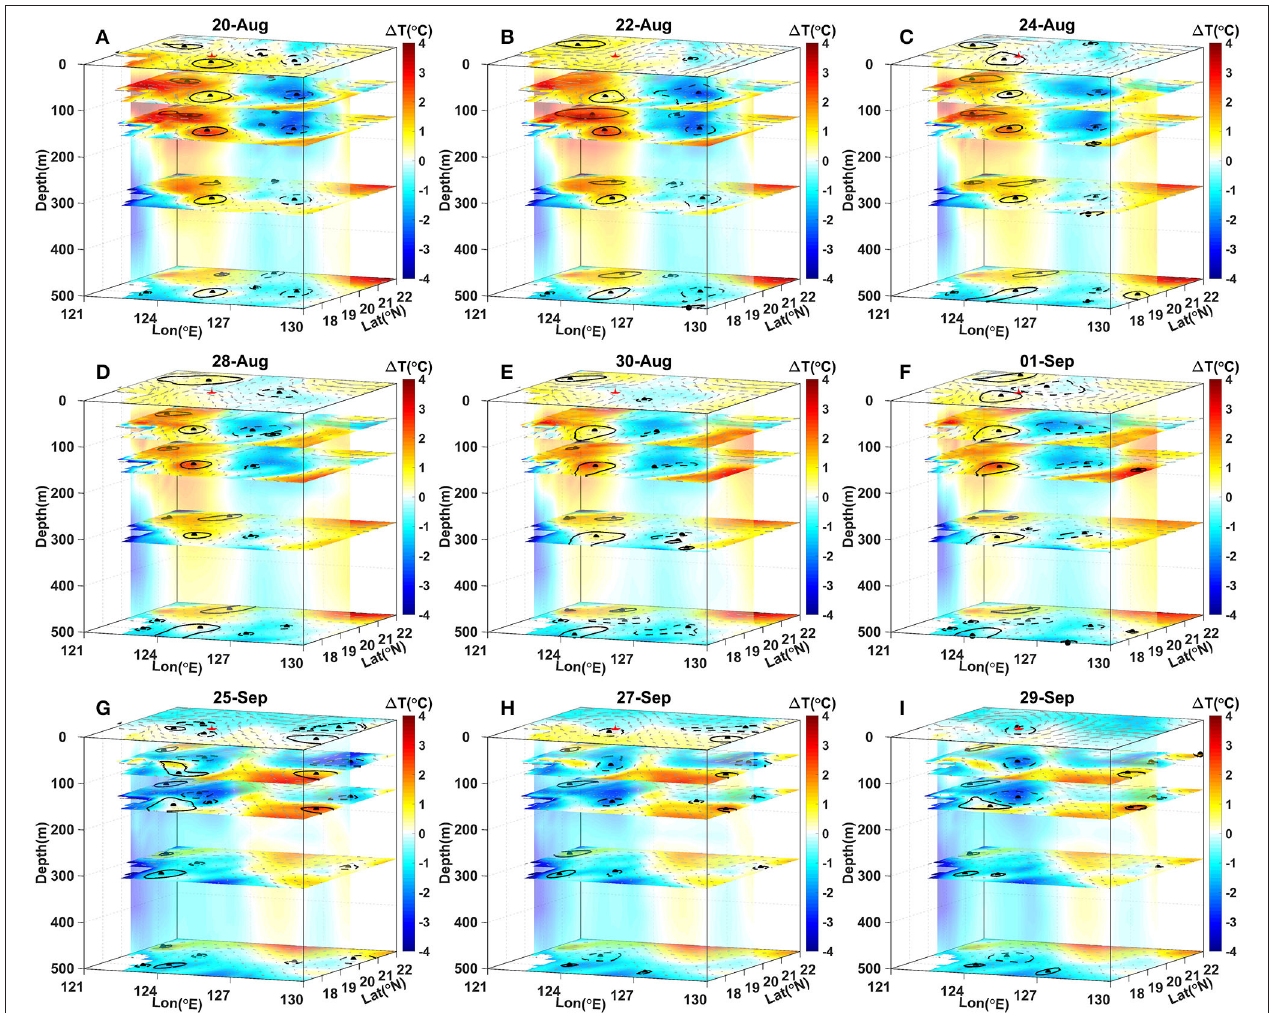
FIGURE 4 | Three-dimensional structures of temperature profiles before TCs (A, D, G) , during TCs (B, E, H) , and after TCs (C, F, I) . (A–C) TC Bailu, (D–F) TC Lingling, (G–I) TC Mitag. The black lines in (A–I) are the edge of cyclonic eddy (dashed lines) and anticyclonic eddies (solid lines) detected by using the velocity vector method. TCs, tropical cyclones.